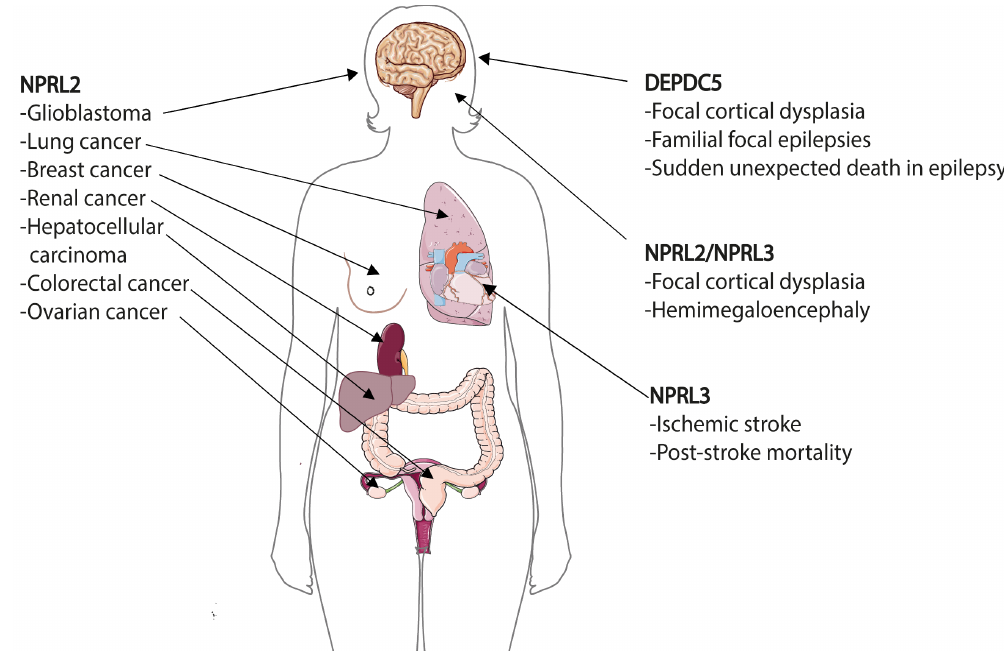
Figure 6. Deregulation of GATOR1 components in different human diseases. Expression of GATOR1 components is downregulated in many cancers and GATOR1-related neurological disorders. In striking contrast to GATOR2, many pathological mutations in GATOR1 genes have been reported. These mutations are mainly related with two main types of human diseases — cancer and epilepsy. Although the alternations in sequence and gene expres- sion associated with these pathologies have been reported for all three GATOR1 genes,